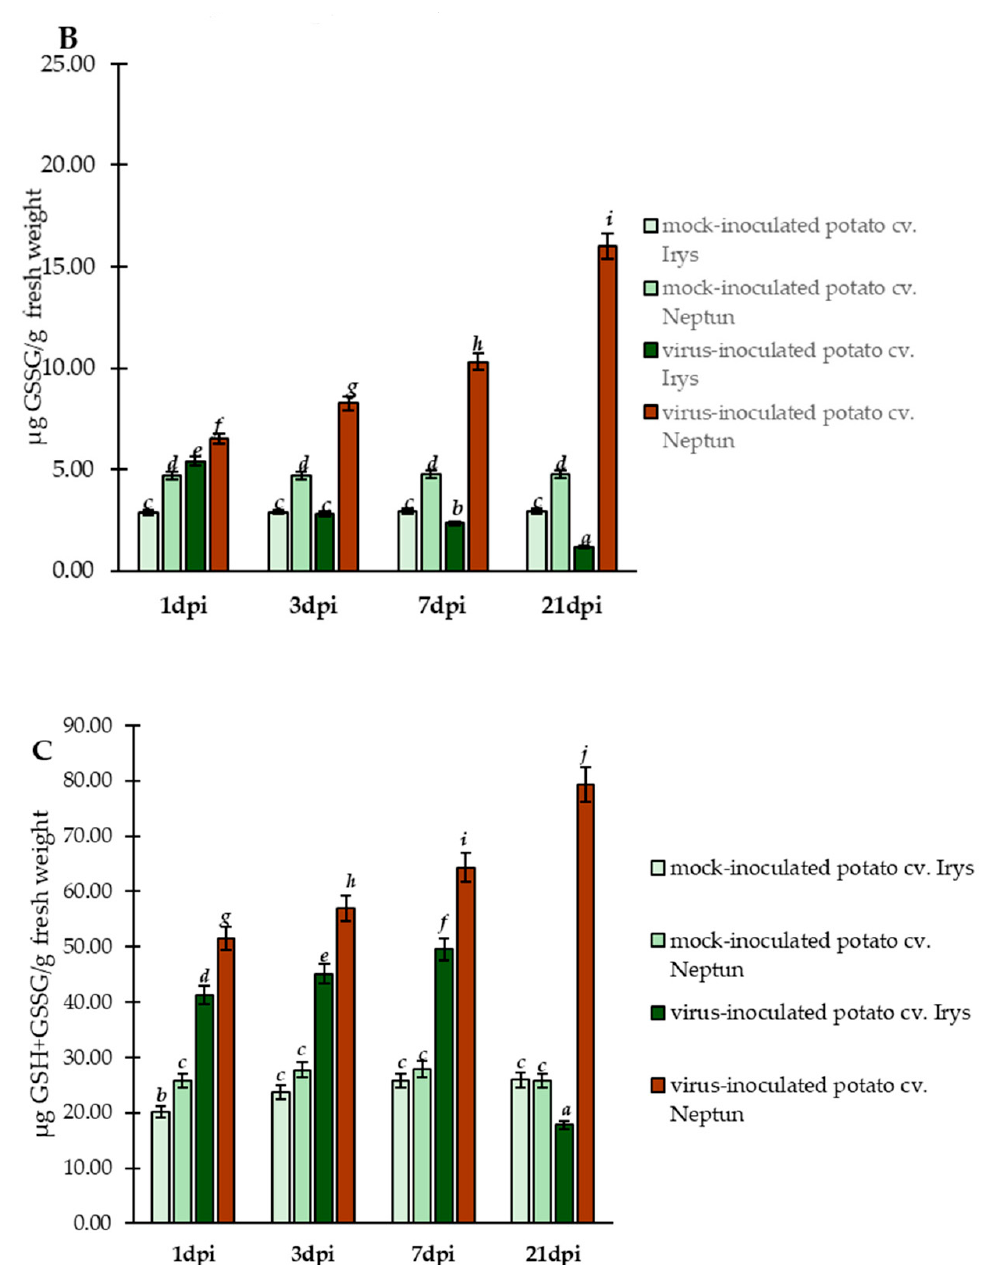
Figure 3. The mean concentration of reduced (GSH) ( A ) and oxidized (GSSG) ( B ) glutathione in the leaves of PVY NTN and mock inoculated susceptible Irys potato and resistance Neptun potato plants between 1 and 21 dpi. ( C ) The mean of summary concentration of reduced (GSH) and oxidized (GSSG) glutathione in the leaves of PVY NTN and mock inoculated Irys and Neptun potato plants between 1 and 21 dpi. Using ANOVA and Tukey’s HSD test, the mean concentrations of GSH and GSSG were calculated at p < 0.05. The statistically significant values are marked by letters above the